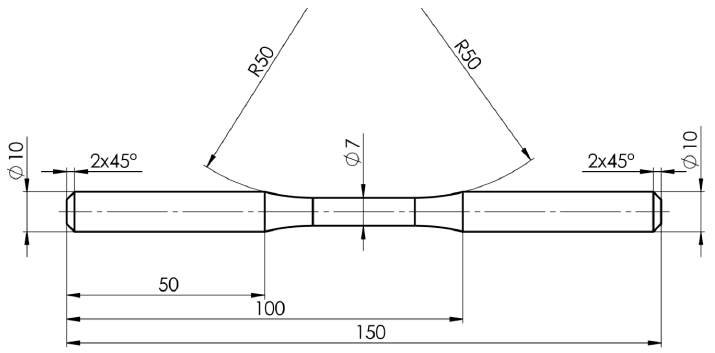
Figure 2. Drawing of the test specimen used for rotating-bending fatigue tests. Dimensions are given in mm.